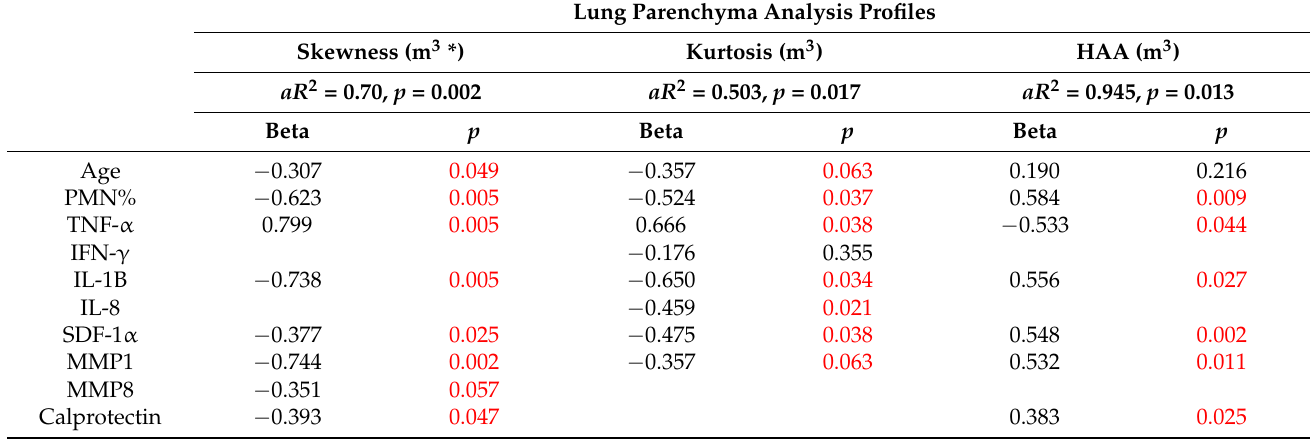
Table 4. Multivariate regression model for quantitative lung parenchyma analysis profiles and chemokines in the peripheral blood of CPA